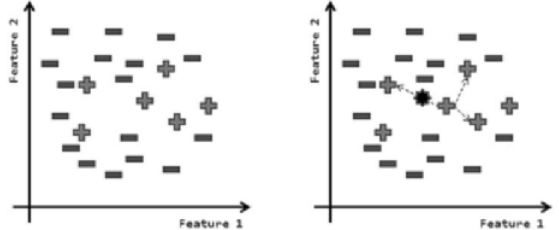
Figure 2. Idea of the SMOTE algorithm. On the left an imbalanced data set and on the right a synthetic object